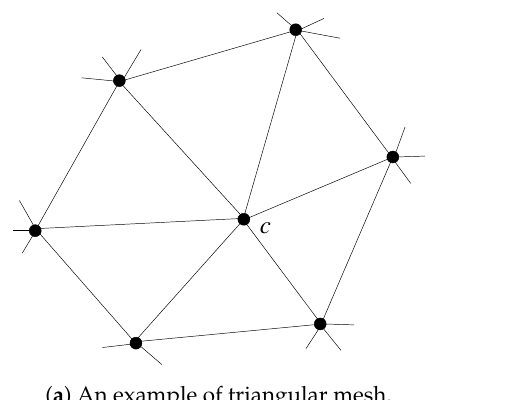
( a ) An example of triangular mesh. ( b ) Voronoi dual mesh. Figure 1. Definitions of the employed computational mesh. Some notation is introduced and clarified in the